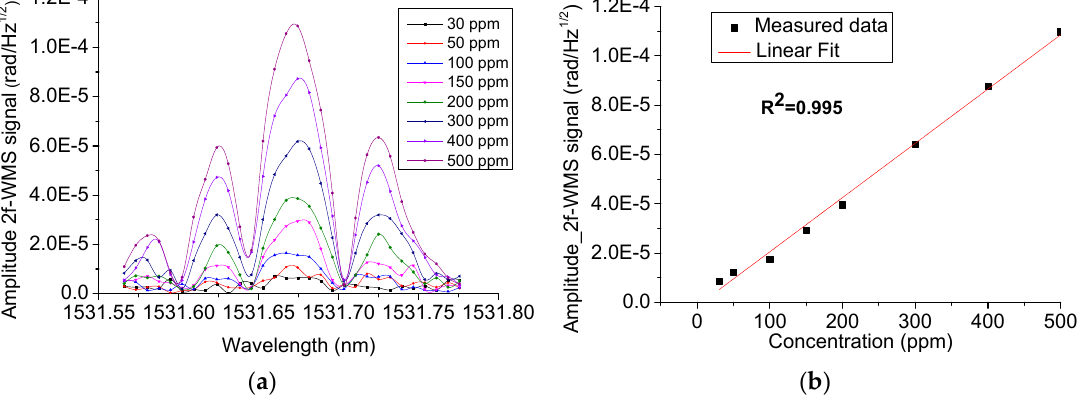
Figure 12. Amplitude ( a ) and linear fitting ( b ) of 2f-WMS Photoacoustic signal measured by optical microphone for different NH 3 concentrations. The pressure is set to 1 atm, and the temperature to 296 K.